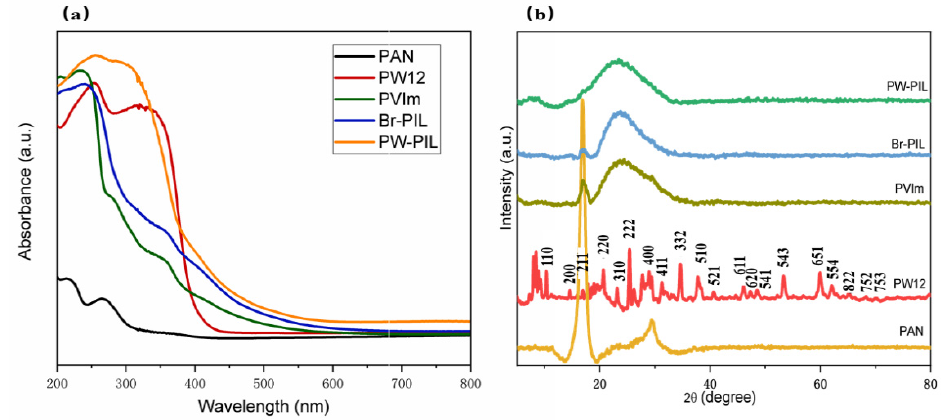
Figure 3. ( a ) The UV-vis diffuse reflectance spectra of PAN, Br-PIL and PW-PIL, PW12. ( b ) XRD patterns of PAN, PW12, PVIm, Br-PIL and